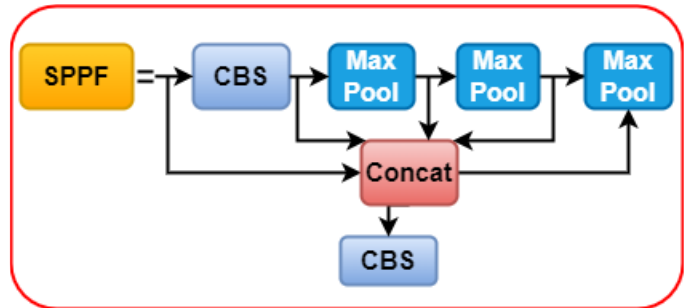
Figure 4. The flowchart of spatial pyramid pooling fast.